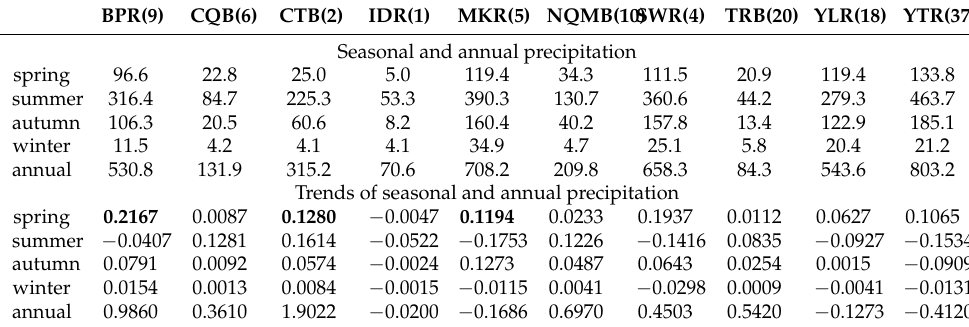
Table 1. Seasonal and annual precipitation (mm) and trends (mm · y − 1 ) over the ten river basins during 1963–2015. Bold fonts represent statistically significant trends ( p < 0.05). Numbers in brackets denote the numbers of weather stations that are located in each of the basins.